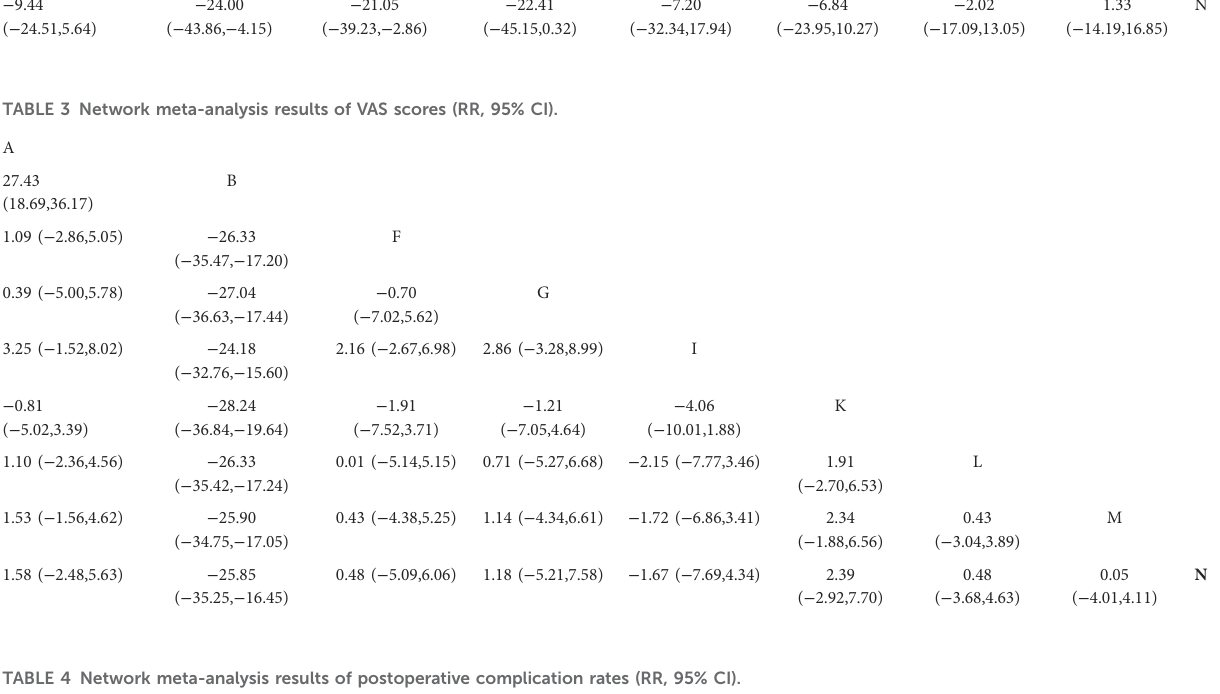
TABLE 4 Network meta-analysis results of postoperative complication rates (RR, 95%